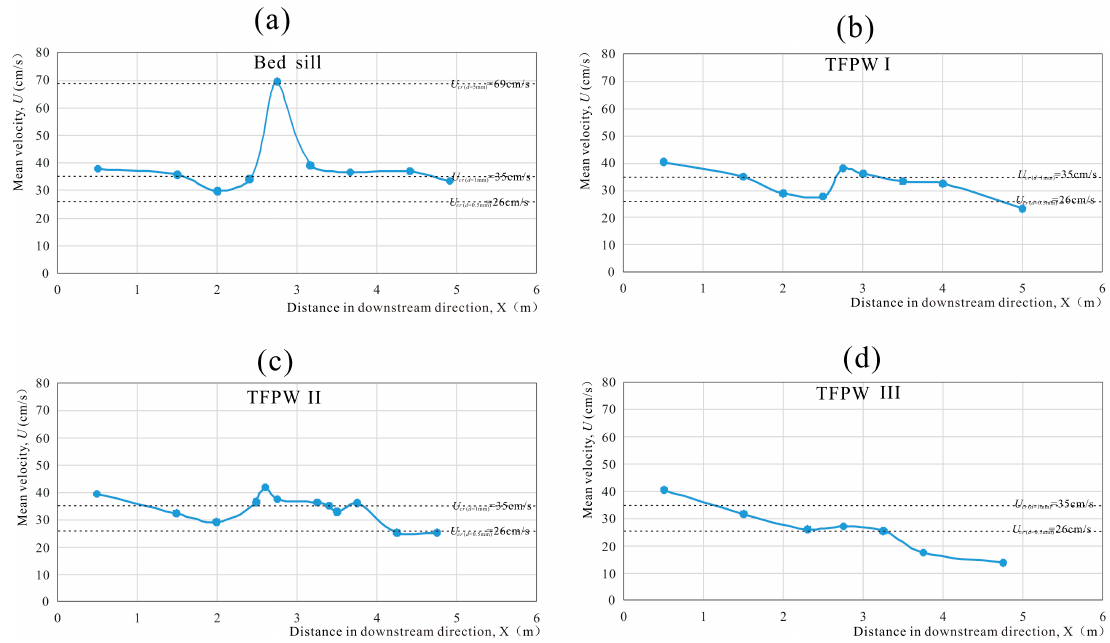
Figure 11. The diagram of velocity variation along the central axis of the flume: ( a ) with bed sills; ( b ) with random Single TFPW; ( c ) with random Double TFPW; and ( d ) with paved Single TFPW.